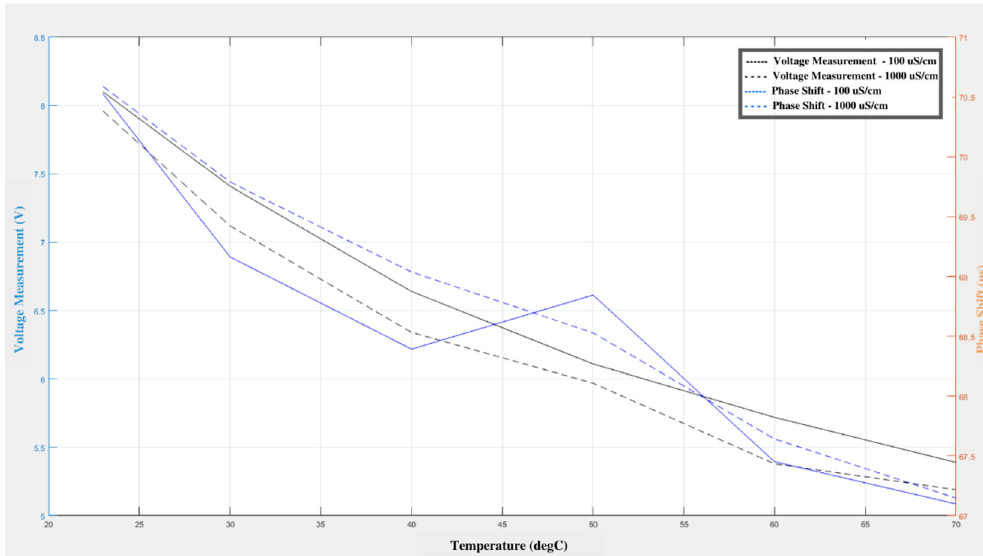
Figure 4. Variation in voltage and phase shift in response to changes in the conductivity and temperature of the water.